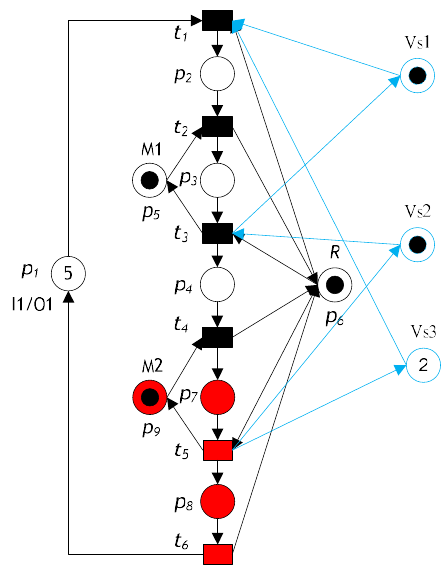
Figure 8. Controlled reconfigurable S 3 PR net by addition of new machine.